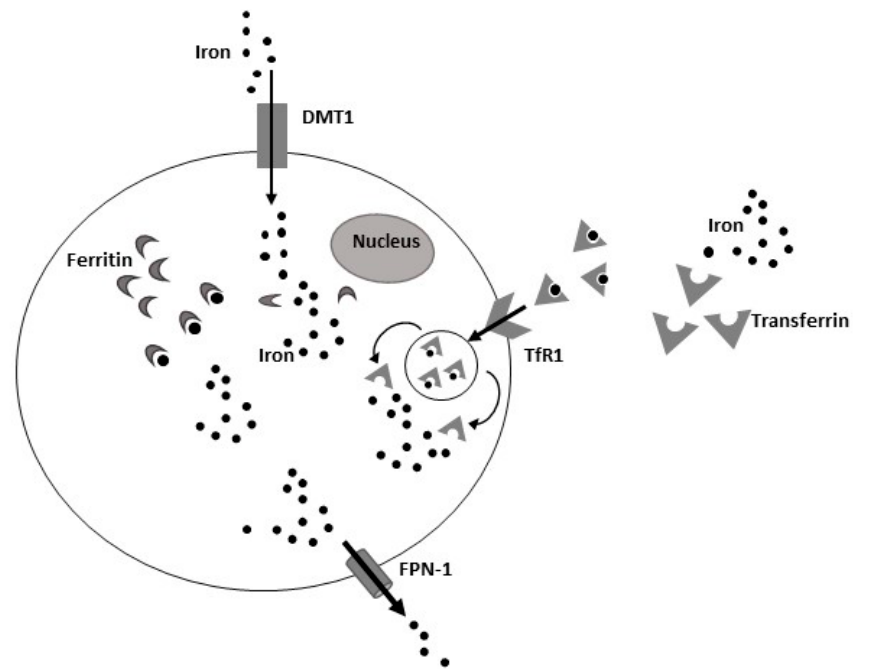
Figure 1. Iron metabolism. Several biomolecules modulate iron metabolism, contributing to its import and export in cells. Transferrin (Tf) is an important glycoprotein responsible for the transport of circulating iron in its inert state. The Transferrin Receptor-1 (TfR-1) and the Divalent Metal Transporter 1 (DMT1) are the main iron importers, located on cell surface, responsible for iron internalization in cells. TfR-1 recognizes and internalizes the complex Tf-ferric iron (Fe 3+ ) into cells, where iron is released, while DMT1 binds and internalizes reduced iron (Fe 2+ ). Once iron has entered the cell, it can be used by the mitochondrion for metabolic reactions, or it can be bound in its inert form by ferritin. Then, excess iron is released by cell through the only known iron efflux protein ferroportin-1 (FPN-1).